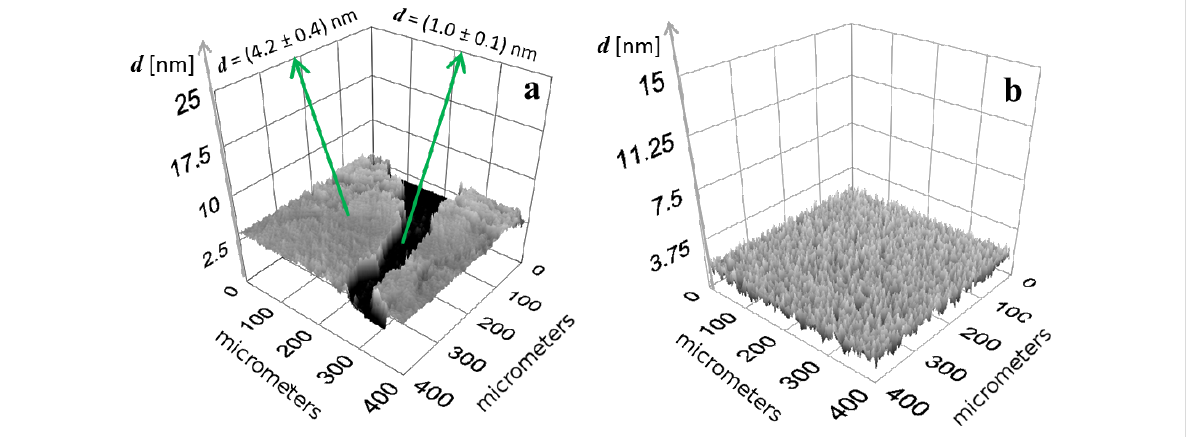
Figure 4: Thickness maps of PPDL-D4 (a) and PLGA (b) derived from Δ -maps corresponding to Figure 3b and Figure 6b, respectively. For PPDL-D4, the thickness values for the slabs of around 4 nm and 1 nm for the surrounding layer were obtained.